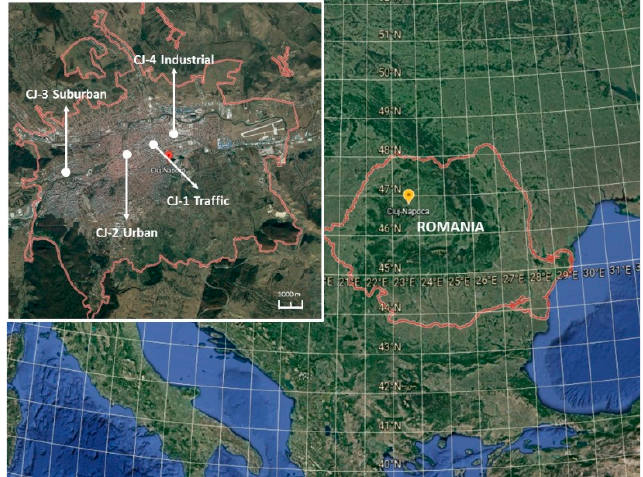
Figure 1. Location of the monitoring stations in Cluj-Napoca city.